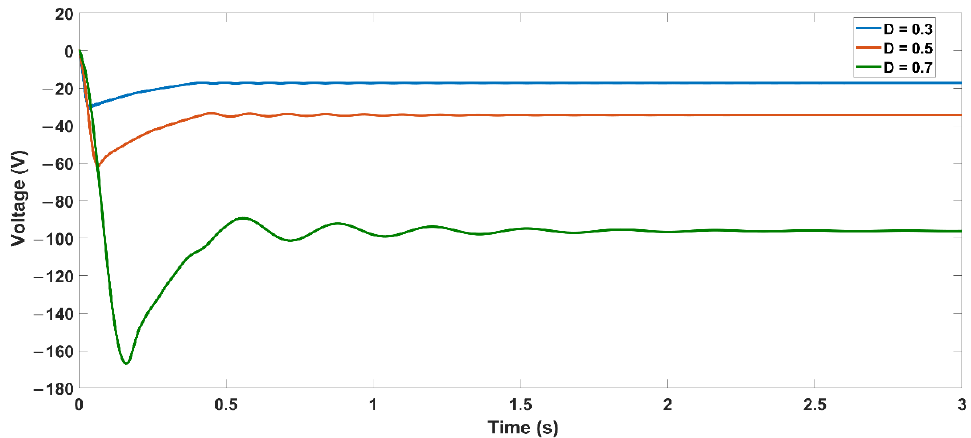
( h ) Figure 7. Voltages across diodes and MOSFET at D = 0.5 and V in = 3V during ON and OFF modes.